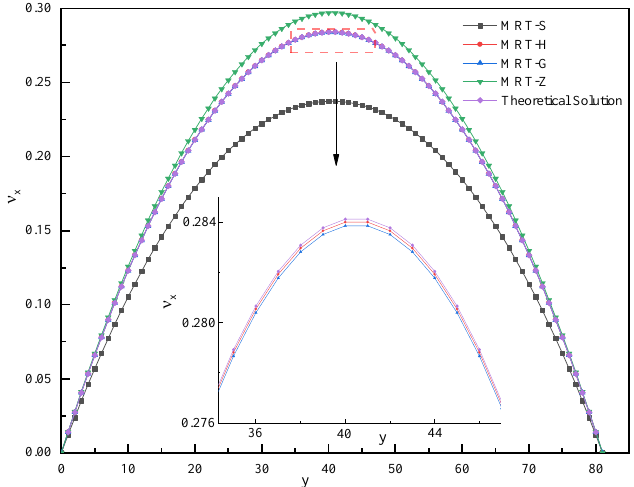
Figure 2. The profiles of x v along vertical centerline of ROI (x = 140.5).